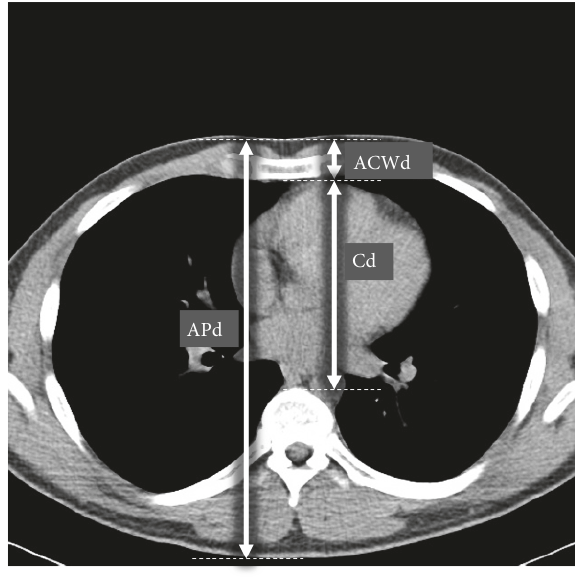
Figure1:MeasureddiametersonanaxialchestCTimageatthelevel of the lower half of the sternum. APd was defined as the distance from the anterior skin to the posterior skin. ACWd was defined as the distance from the anterior skin to the posterior sternum. Cd was defined as the distance from the posterior sternum to the anterior vertebral body. APd: anteroposterior diameter; ACW: anterior chest wall diameter; C: compressible